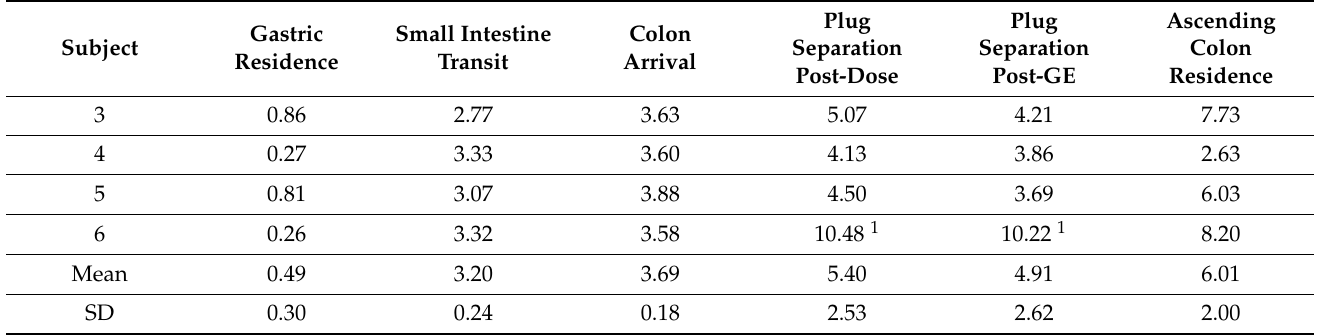
Table 2. Transit and plug separation times (h) of placebo units in six fasted volunteers. Adapted with Table 2. Cont. permission from Ref. [47]. 1997, Taylor & Francis.